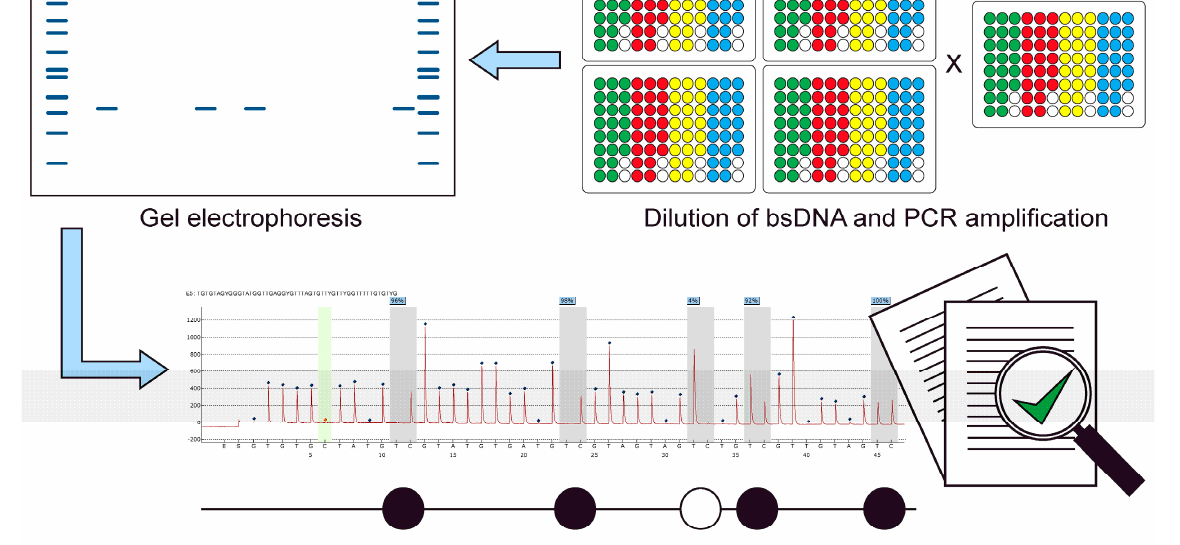
Figure 1. Overview of the limiting dilution bisulfite pyrosequencing (LDBPS) procedure for pools of individually isolated neurons using laser capture microdissection (LCM). Tissue from post-mortem brains is sampled and stained using a cell type-specific marker. Neurons are then isolated and divided into small cell pools. DNA derived from these neurons then undergoes a bisulfite conversion (BSC) treatment and is subsequently diluted to a single allele level. The bisulfite converted DNA (bsDNA) is then amplified twice by means of a (semi-)nested polymerase chain reaction (PCR) in multiplex-singleplex formation. Product-yielding reactions are then visualized on an agarose gel and the cytosine-phosphate-guanine (CpG) methylation status of these products is then profiled by means of pyrosequencing.